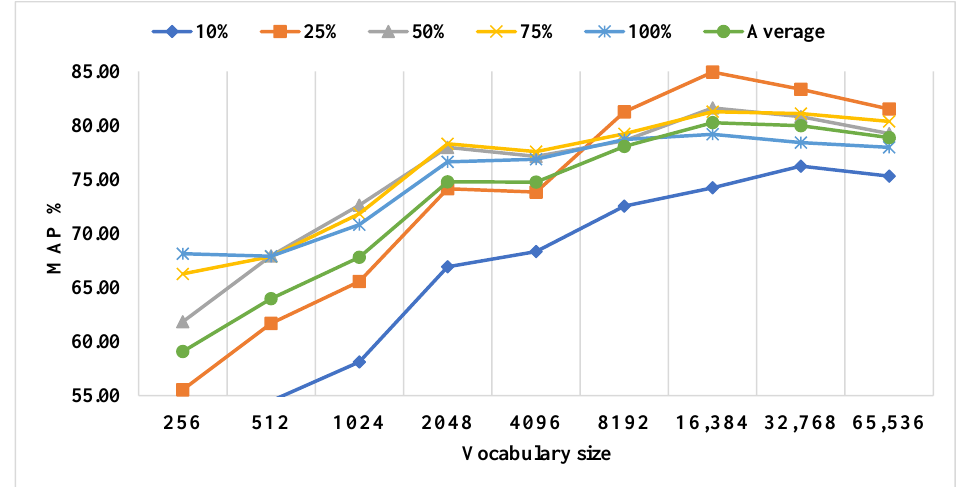
Figure 14. KFFVW on various vocabularies sizes and BFS on Oxford Flower-17 dataset. It was interesting to find the best combination between SIFT, FAST, SURF, and ORB to produce the HKFV. The performance and execution time comparison results between +BFS were included as Table 2. The comparison in Table 3 provides execution time and performance between (SURF+BFS), (FAST+BFS), (HKFV), and (HKFV+BFS) validates the effectiveness of each component in the framework and indicates whether each part is necessary for the